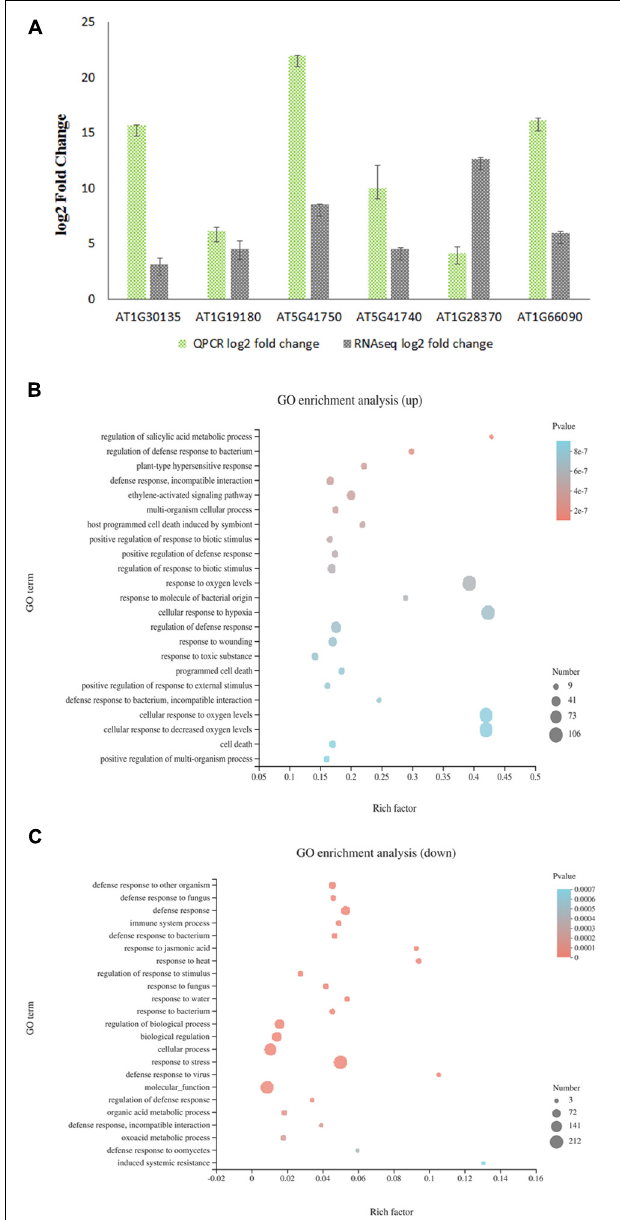
FIGURE 4 | Transcript profiling of AtJAZ8 overexpressor plants. (A) Validation of the RNA-Seq data by quantitative RT-PCR. Six differential expression genes in AtJAZ8 overexpressor plants compared with control plant lines in the RNA-seq experiment were selected for validation by qRT-PCR. (B) GO term enrichment for 428 upregulated genes using Database for Annotation and Visualization. (C) GO term enrichment for 268 downregulated genes using Database for Annotation and